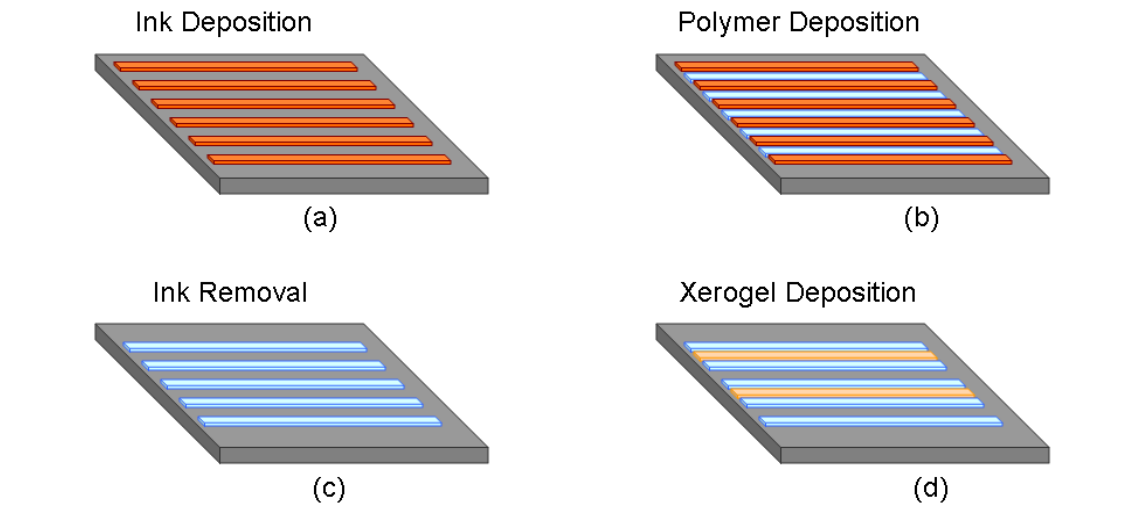
Figure 3. Fabrication process flow for the development of polymeric waveguide support platform using direct-dispense process and the immobilization of xerogel mateirals.